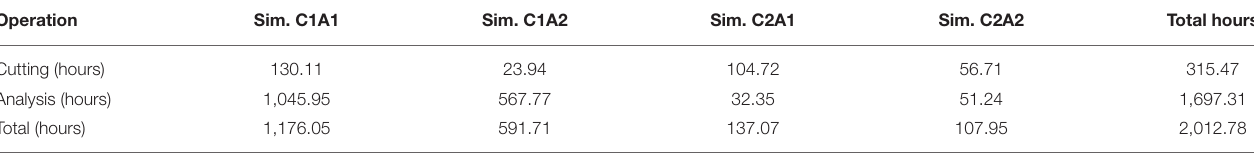
TABLE 4 | Summary of simulated hours for the combination of possible biopsy cutting and analysis.